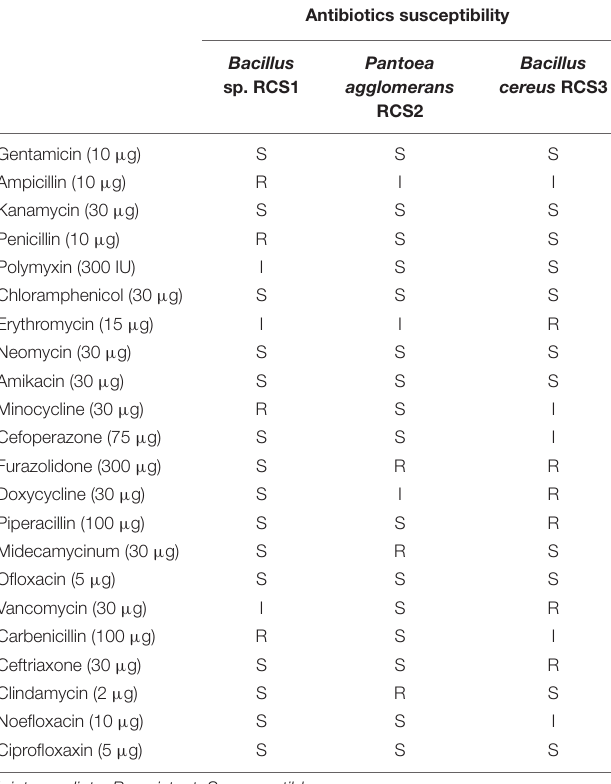
TABLE 2 | Antibiotics susceptibility of isolated bacterial strains.